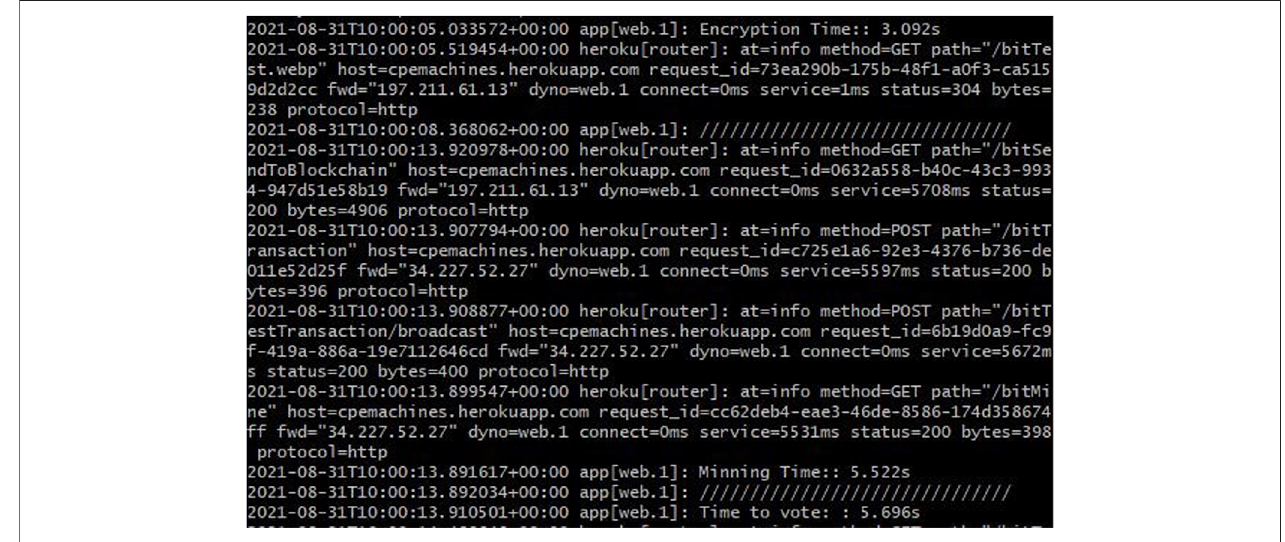
FIGURE 6 | Heroku CLI window of the developed system.